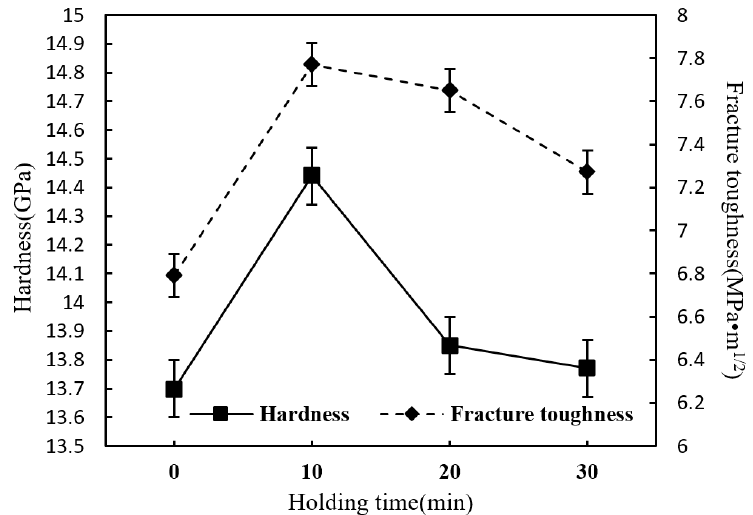
Figure 12. Effect of holding time on hardness and fracture toughness of the sintered Si 3 N 4 /n-SiC ceramics (sintering temperature for 1600 °C ) .